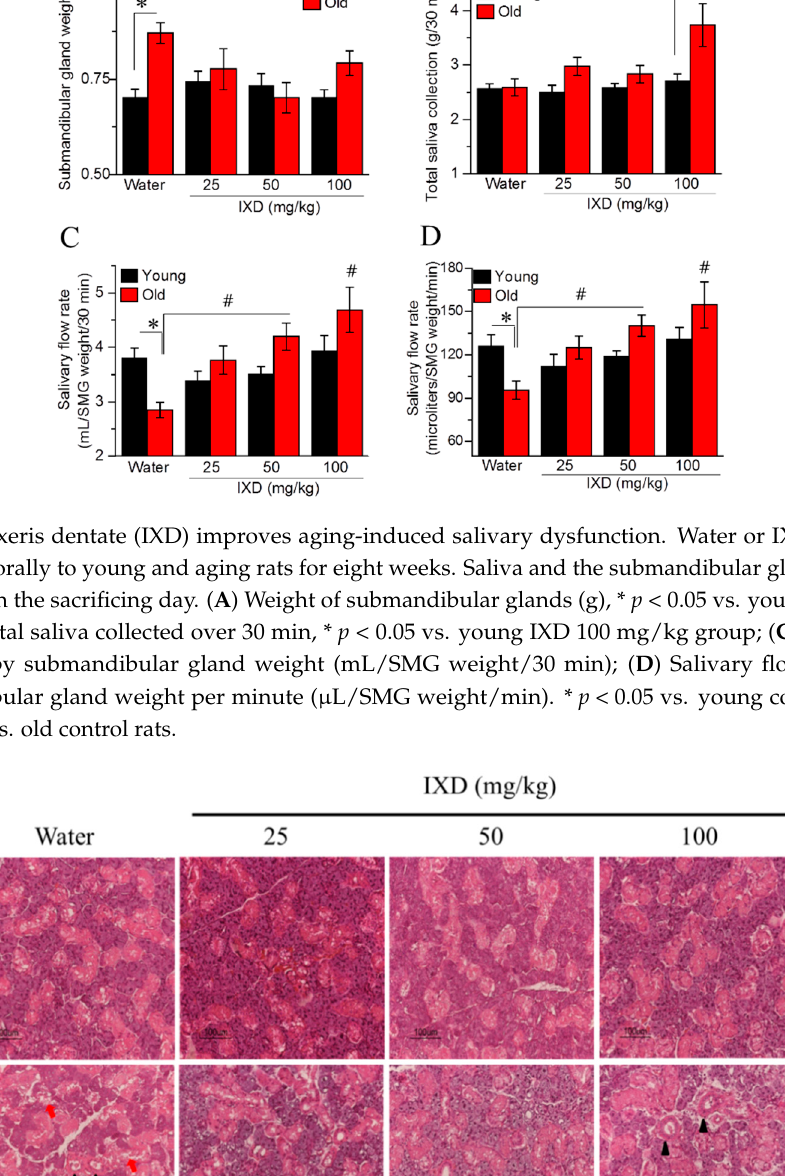
Figure 2. H and E staining was performed on formalin-fixed, paraffin-embedded submandibular gland sections to determine the morphological changes in water- and IXD-treated young and aging rats. Black arrowheads denote striated ducts, and red arrows indicate the acinar cells of the submandibular glands. Magnification: 400×, Scale bar: 100 µm.